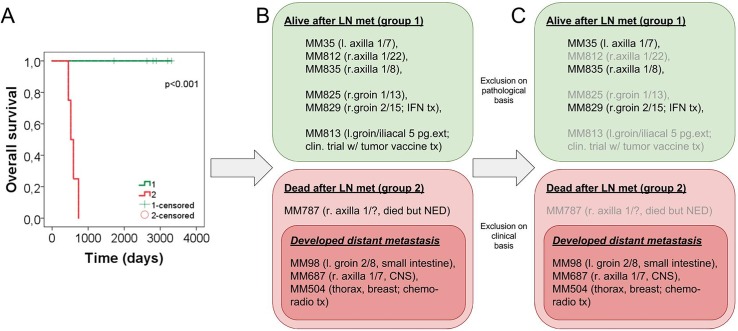
(A) Overall survival of the prognostic groups, “survivors” (group 1) and “non-survivors” (group 2). (B) All ten cases were subjected to rigorous review both on histological and clinical grounds. (C) Those were omitted (lighter grey text), where the tumor content of the examined tissue was low (<10%) or the clinical follow-up data resulted in non-disease-specific outcome measures (one patient in group 2 died without evidence of malignancy). Abbreviations: l: left; r: right; LN met: lymph node metastasis; CNS: central nervous system; tx: therapy. Numbers in brackets mean lymph nodes containing metastatic melanomas / all lymph nodes dissected from either the groin or the axilla: nmetastatic/nall.